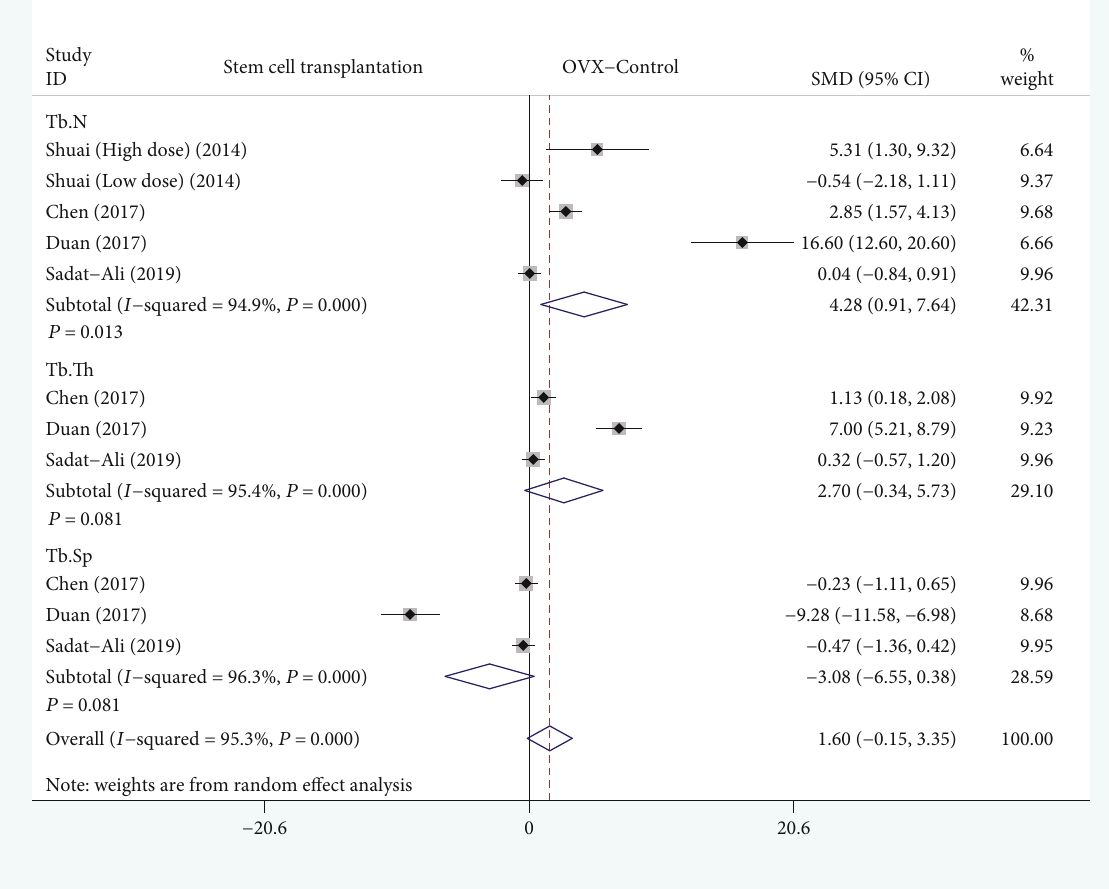
Figure 7: Forest plot showing the e ff ect of the BMSC transplantation group compared with the OVX control group on Tb.N, Tb.Th, and Tb.Sp. Tb.N: trabecular number; Tb.Th: trabecular thickness; Tb.Sp: trabecular